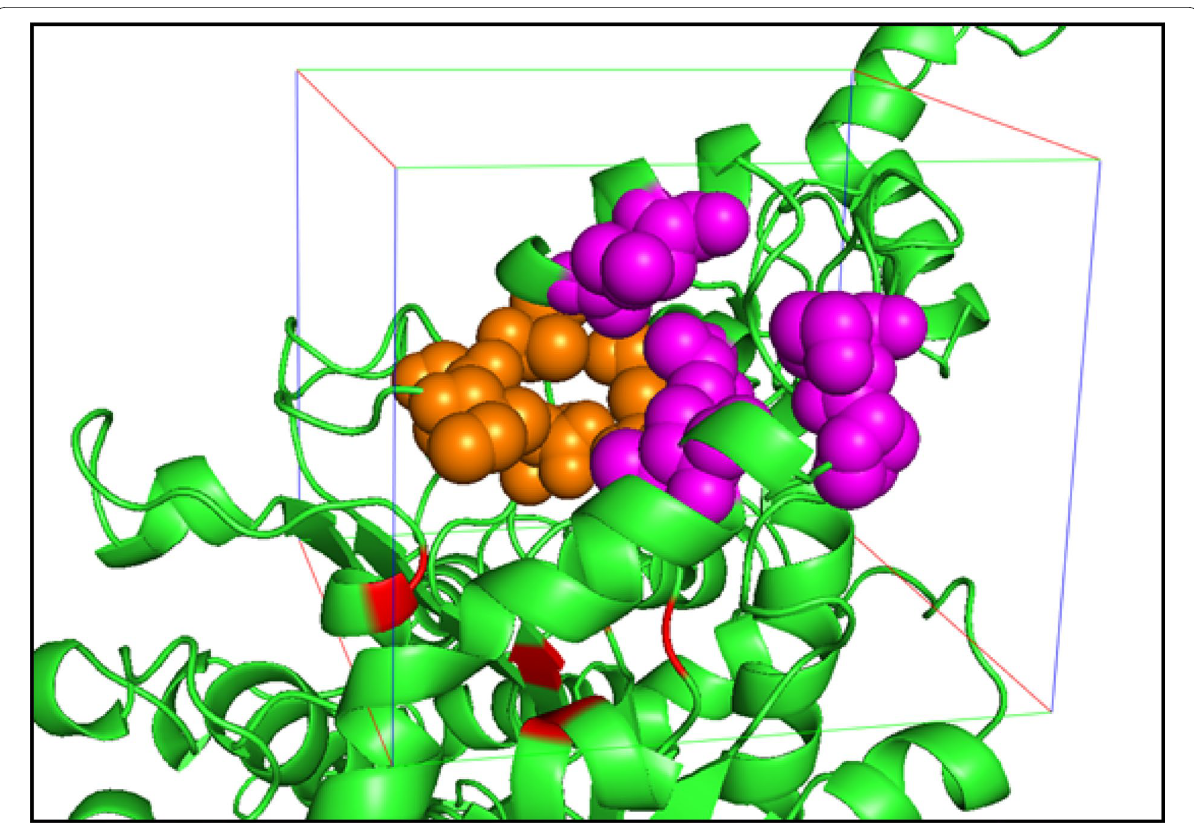
Fig. 7 Molecular docking pocket of